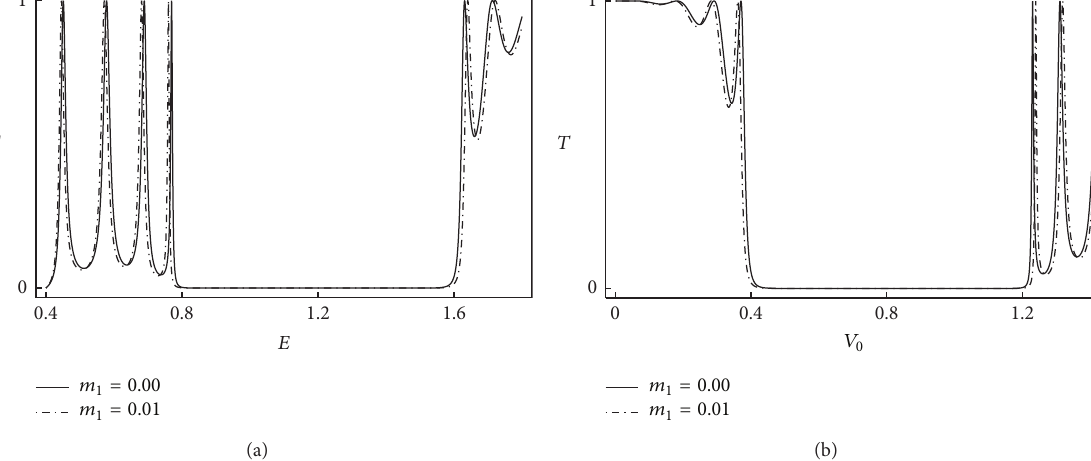
Figure 3: The effect of position dependent mass for the GAWSp on transmission coefficient. (a) shows 𝑉 0 = 4 , 𝐿 = 1.2 , 𝑏 = 10 , 𝑝 = 2.2 , ̃ 𝑝 = 2.1 , 𝑞 = 1 , ̃𝑞 = 1 , and 𝑚